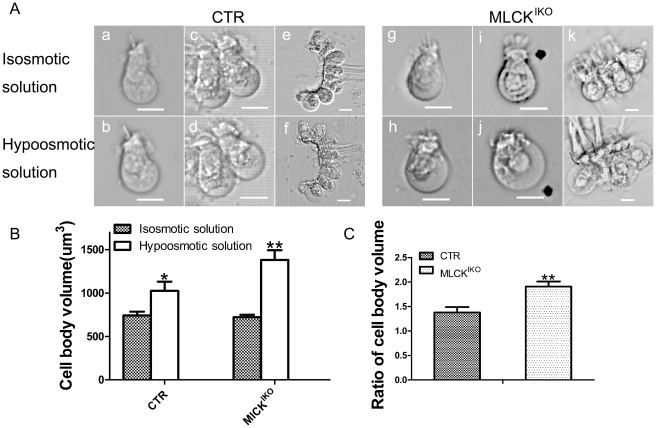
Volume alteration of isolated IHCs upon hypoosmotic treatment.(A) The morphology of IHCs isolated from 4-month-old CTR (a, c, e) and MLCKIKO mice (g, i, k) in isosmotic D-Hank's solution. CTR (b, d, f) and MLCKIKO (h, j, l) IHCs were also imaged after treatment with hypoosmotic solution (a mixture of D-Hank's solution and water at a ratio of 1∶2) for 10 min. Scale bars: 10 µm. (B) Quantification of the change in IHC volume induced by hypoosmotic treatment. (C) The ratio of the changes in the cell body volume induced by hypoosmotic treatment. The error bars represent means ± S.E., *P<0.05, **P<0.01.